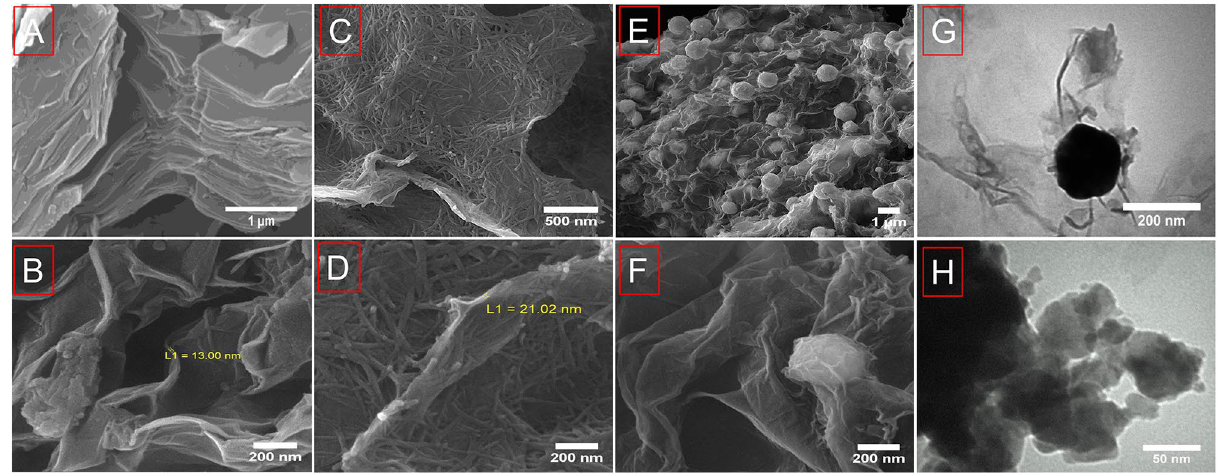
Figure 2. FE-SEM images of ( A , B ) GO, ( C , D ) CoNi 2 @rGO and ( E – F ) NiTe 2 -Co 2 Te 2 @rGO; and TEM images of